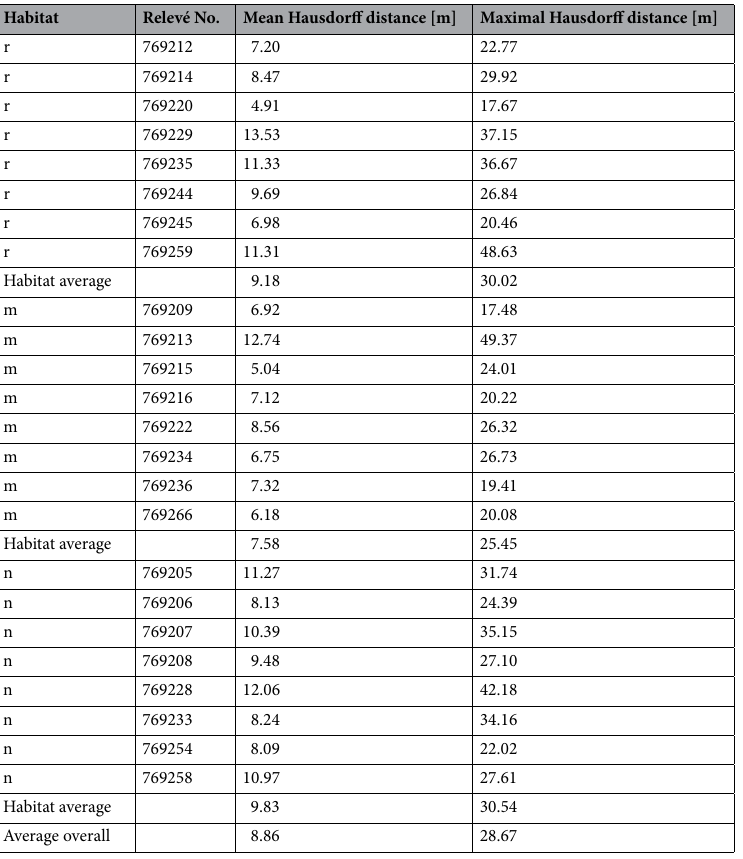
Table 2. Results of 24 semiautomatic segmentation and belonging GPS tracks compared by the Hausdorff distance (values given in meters). Abbreviations to habitats: n – planted spruce forest, m – 9130 – Asperulo- Fagetum beech forests, and r – 9180 – Tilio-Acerion forests of slopes, screes, and ravines.